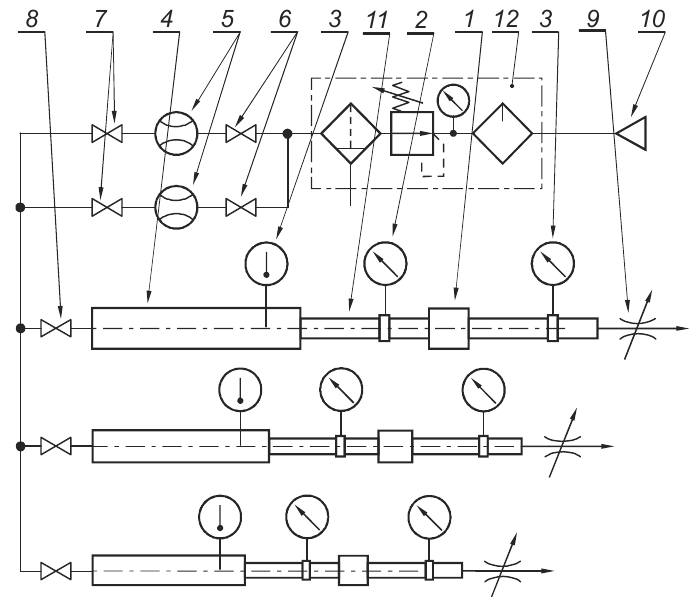
Figure 11. Diagram of the test stand for determining flow-rate characteristics.